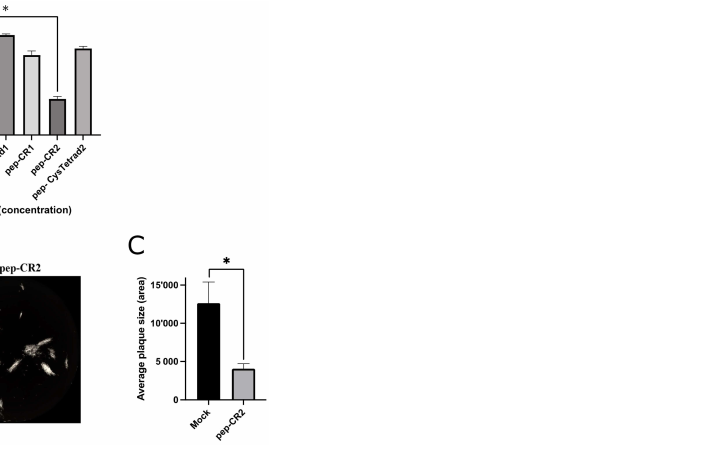
Figure 3. ( A ) Inhibition of virus growth upon pep-CR2 treatment. Cells (human foreskin fibroblasts (HFF)) were pretreated with 10 µ M concentration of control (DMSO), pep-control, pep-CysTetrad1, pep-CysTetrad2, pep-CR1 and pep-CR2 (in triplicates) and infected with HCMV at an MOI of 3.0. Cells were harvested at 5 dpi (days post infection) and virus titers were assessed on HFFs. Data were analyzed by Student’s t -tests, comparing the means of DMSO control and the peptide-treated group. ( B ) GFP+ images showing plaque size comparison in pep-CR2 and mock-treatment control group. Cells were pretreated with pep-CR2 (10 µ M) and mock for 1 h (in triplicates) before infecting them with HCMV at a low MOI of 0.1. Cells were fixed at 10 dpi and virus yield was measured by counting the number of plaques. Images were acquired on a Cytation5 (BioTek Instruments, USA) cell-imaging reader with 4X magnification. ( C ) Plaque size comparison between pep-CR2 and mock-treated cells. Individual plaque sizes were measured by counting the area of the plaques in ImageJ software (National Institutes of Health, Bethesda, MD, USA). Standard error of mean was plotted as error bars. Data were analyzed by Student’s t-tests, comparing the means of the test and the control group. A p value of <0.05 was considered significant. An asterisk (*) indicates significant inhibition compared to wild type.